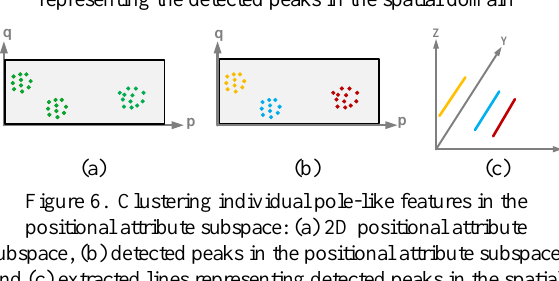
Figure 6. Clustering individual pole-like features in the positional attribute subspace: (a) 2D positional attribute subspace, (b) detected peaks in the positional attribute subspace, and (c) extracted lines representing detected peaks in the spatial domain